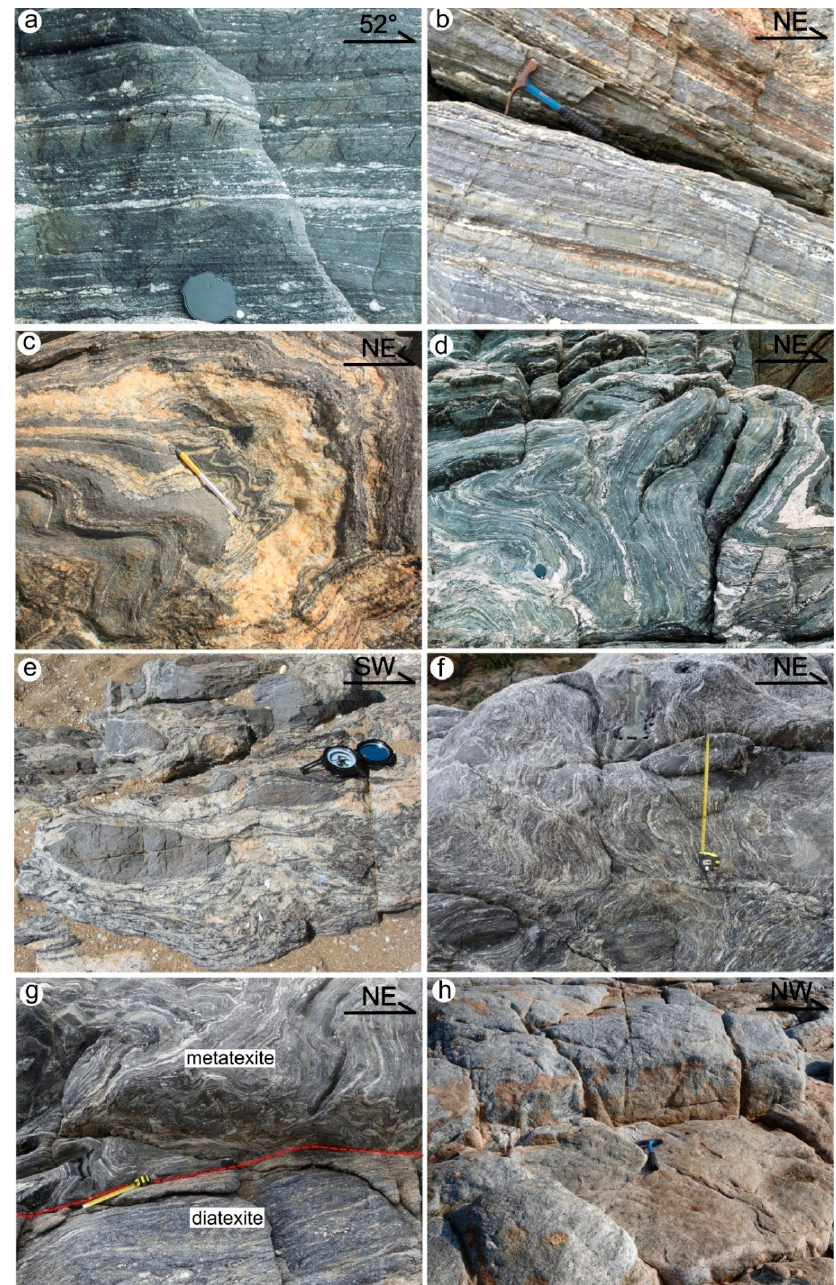
Figure 4. Representative field photographs of the Fuhuling metatexite, diatexite, and biotite monzogranite. ( a ) Approximately parallel orientation of leucosome stroma in metatexites. ( b ) Parallel orientation of leucosome in metatexites. ( c,d ) Variety of folds in the metatexite, for example, ptygmatic folds and superimposed folds in ( c ), rootless folds and tight folds in ( d ). ( e ) Schollen-structured diatexite with lenticular augen of paleosome or melting melanosome. ( f ) Schlieren-structured diatexite with leucosome layers 2–5 mm thick and slightly deformed paleosome blocks. ( g ) Contact between metatexite and diatexite. ( h ) Biotite monzogranite from Fuhuling.